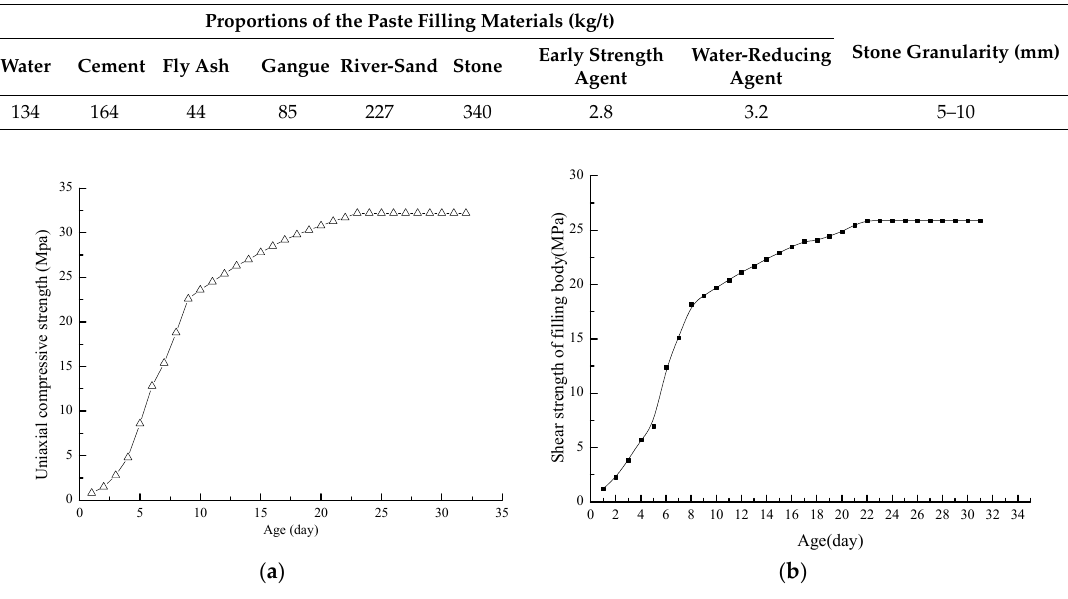
Table 1. Components and proportions of paste materials.